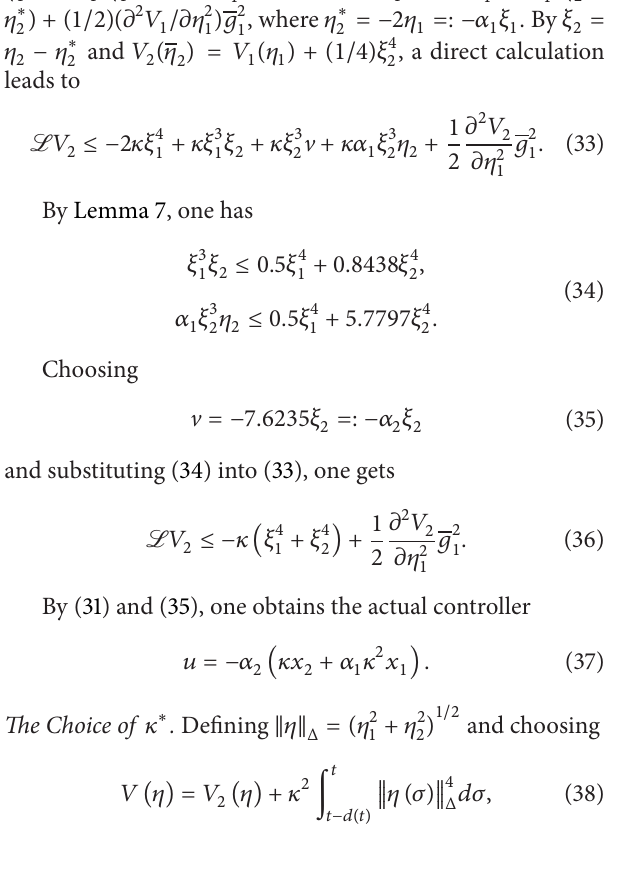
where 𝑔 1 = (1/10)(𝜅𝜂 2 +𝜅𝜂 2 (𝑡−𝑑(𝑡)) cos 𝜅𝜂 2 ) . Choosing 𝜉 1 = 𝑉 (𝜂 ) = (1/4)𝜉 4 𝜂 1 and 1 1